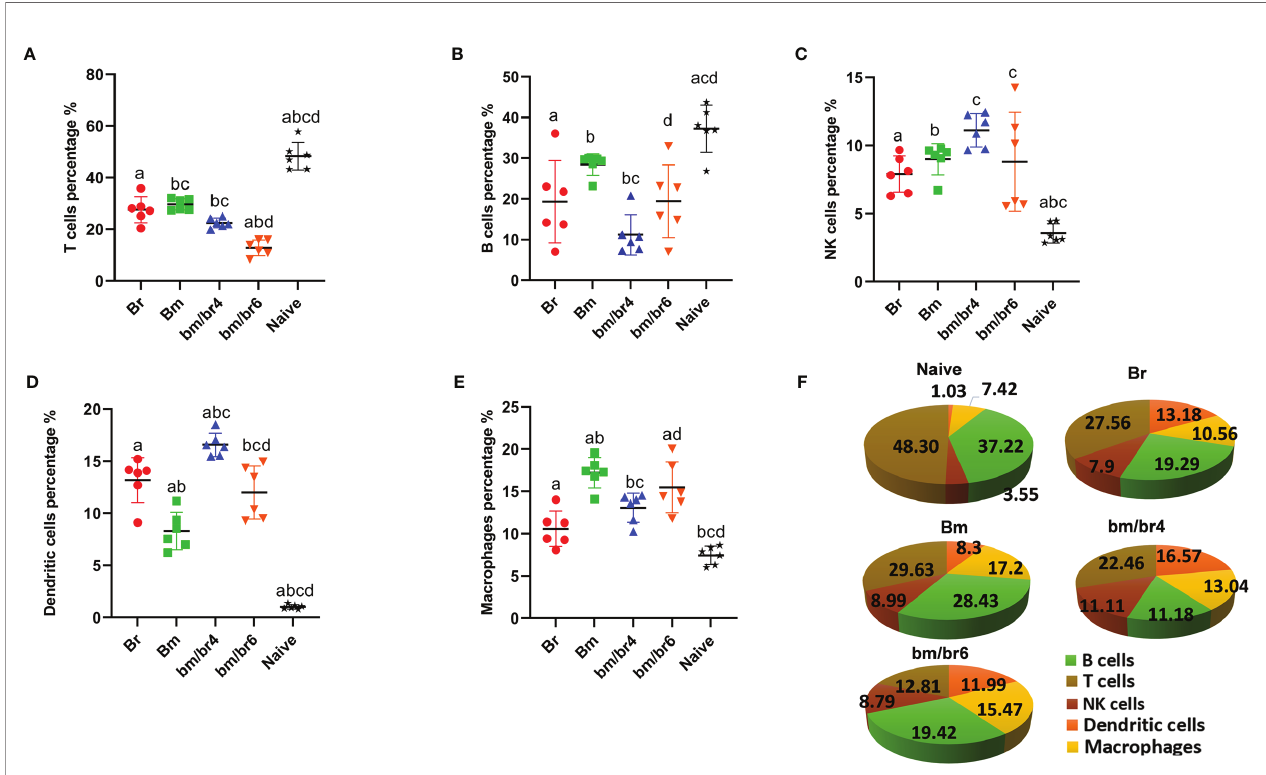
FIGURE 3 | Fluorescence-activated sorting (FACS) analysis of splenic immune cells of mice at day 6 post-challenge infection. Percentage population of each cell type is presented as mean ±SD: (A) CD45 + CD3 + cells (T cells), (B) CD45 + CD19 + cells (B cells), (C) CD45 + CD49b + cells (natural killer cells), (D) CD45 + CD11c + cells (dendritic cells), and (E) CD45 + F4/80 + cells (macrophages). (F) Pie chart representing the population composition of T cells, B lymphocytes, NK cells, dendritic cells, and macrophages in Naive, Br, Bm, bm/br4, and bm/br6 groups. Different letters denote signi fi cant differences between